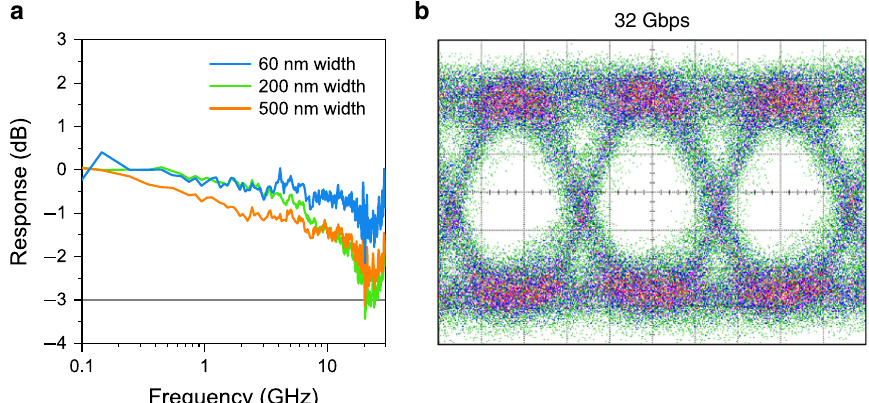
Fig. 5 Electrically and optically pumped light emission. a Measured PL and spectral absorption response spectra ( w = 200 nm). b EL from a ~1 μ m wide device for different applied voltages. Close to 1600 nm, the cutoff of the measurement detector connected to the spectrometer is visible. The inset shows the I – V curve in